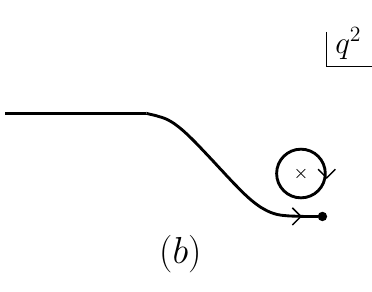
Figure 3 . Difference (circular contour) between continuing: (a) above and (b) below endpoint